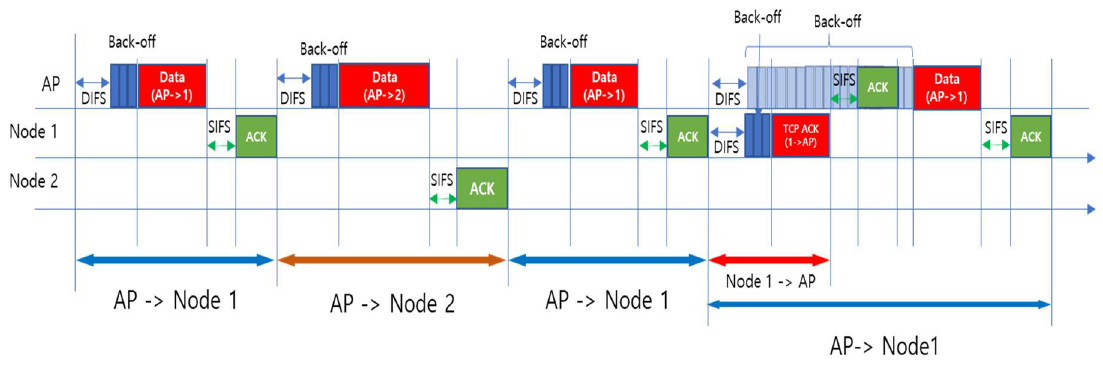
Figure 1. Typical Transmission Scenario.